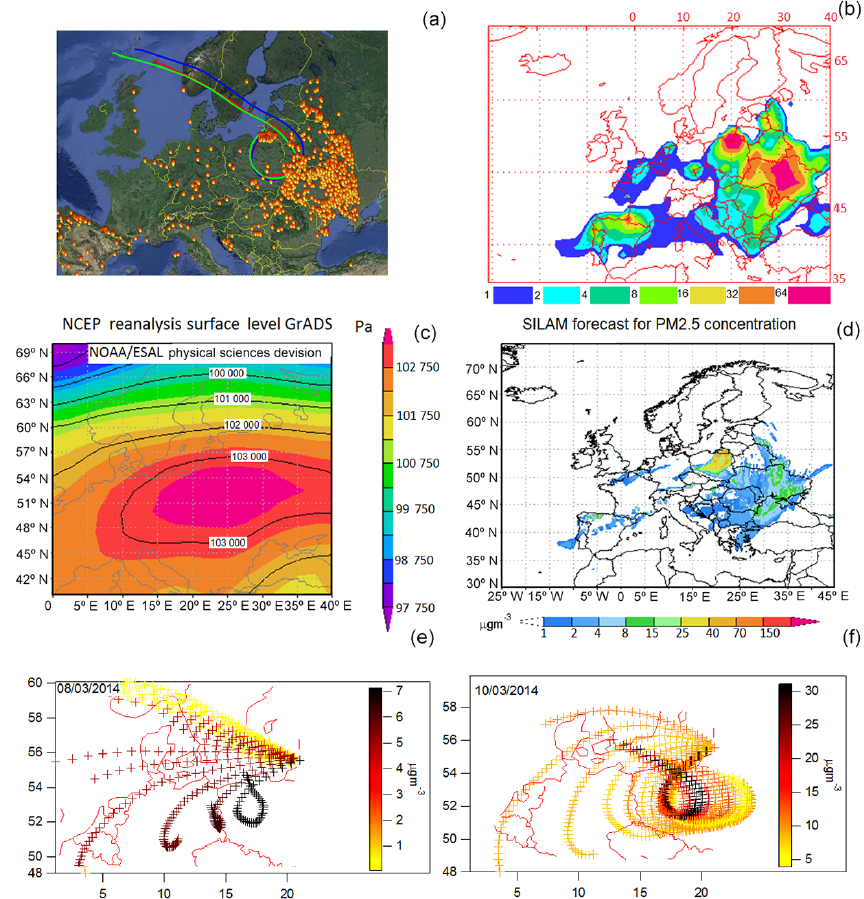
Figure 2. (a) Combined MODIS images observed from the Aqua satellite on 10 March 2014, showing numerous fires due to seasonal grass burning and 72h air mass backward trajectories from the fire regions arriving at Preila at 100 (red), 200 (blue) and 500 (green)m above ground level (a.g.l.). (b) NAAPS model results showing surface smoke concentrations for the strongest stage (10 March 2014) (the color scale (from blue to purple) corresponds to the seven levels of the contours that indicate the smoke mass mixing ratio (µgm − 3 ) at the surface). Smoke optical depth at a wavelength of 0.55µm. The contouring begins at 1µgm − 3 and doubles in magnitude for each successive contour. (c) Pressure level in Pa at the surface for 2.5 ◦ latitude × 2.5 ◦ longitude global grids (NCEP/NCAR Reanalysis 1, 10 March 2014). (d) PM 2 . 5 concentration (µgm − 3 ) forecast utilized by the SILAM chemical transport model during the event of grass fires. (e, f) ACSM organics concentration (µgm − 3 ) (measured in Preila) weighted air mass back trajectories of 48h (for an arrival on 8 (e) and 10 (f) March 2014) with an altitude endpoint of